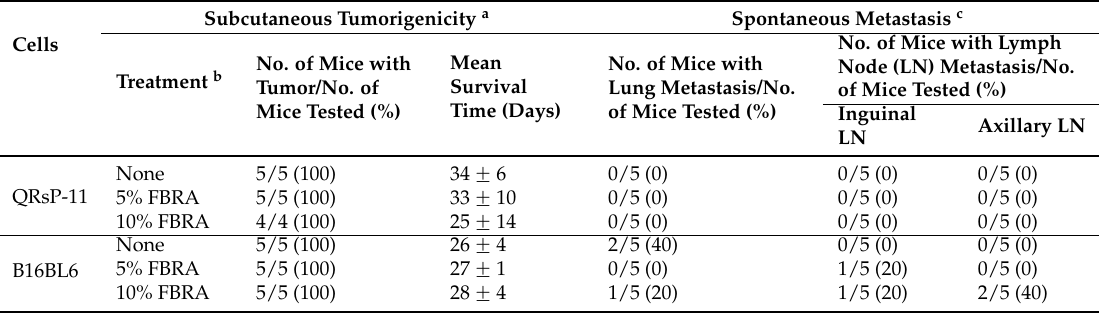
Figure 2. No difference was found in the tumor growth or body weights between basal and FBRA-containing diets. Five × 10 5 QRsP ‐ 11 fibrosarcoma cells ( A ) and 1 × 10 6 B16BL6 melanoma cells ( B ) were implanted into mice subcutaneously. Body weights of mice co-implanted QR-32 cells with gelatin sponge as shown in Figure 1 remained unchanged after FBRA administration (C). Table 2. Tumor incidence and metastatic ability of QRsP-11 tumor cells or B16BL6 melanoma cells were not influenced by FBRA administration.